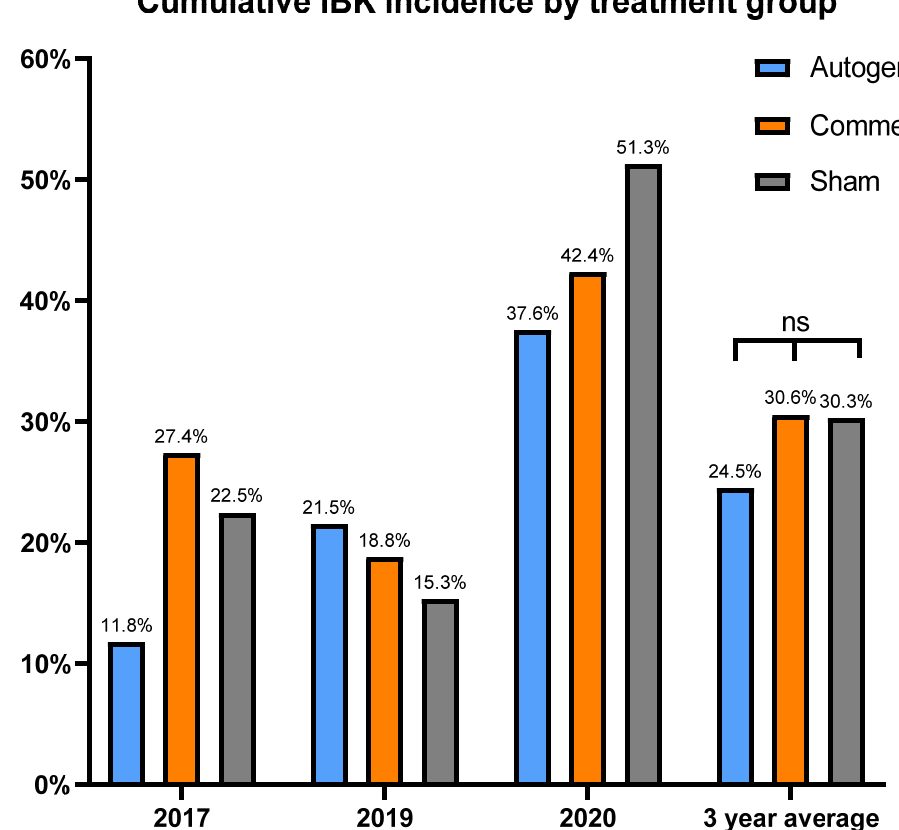
Figure 3. Annual and 3-year average incidence of IBK diagnosis by vaccine treatment group. Percent- ages calculated as the number of IBK diagnoses per calves enrolled each year. Vaccine treatment did not significantly affect IBK incidence. ns = not significant ( p =